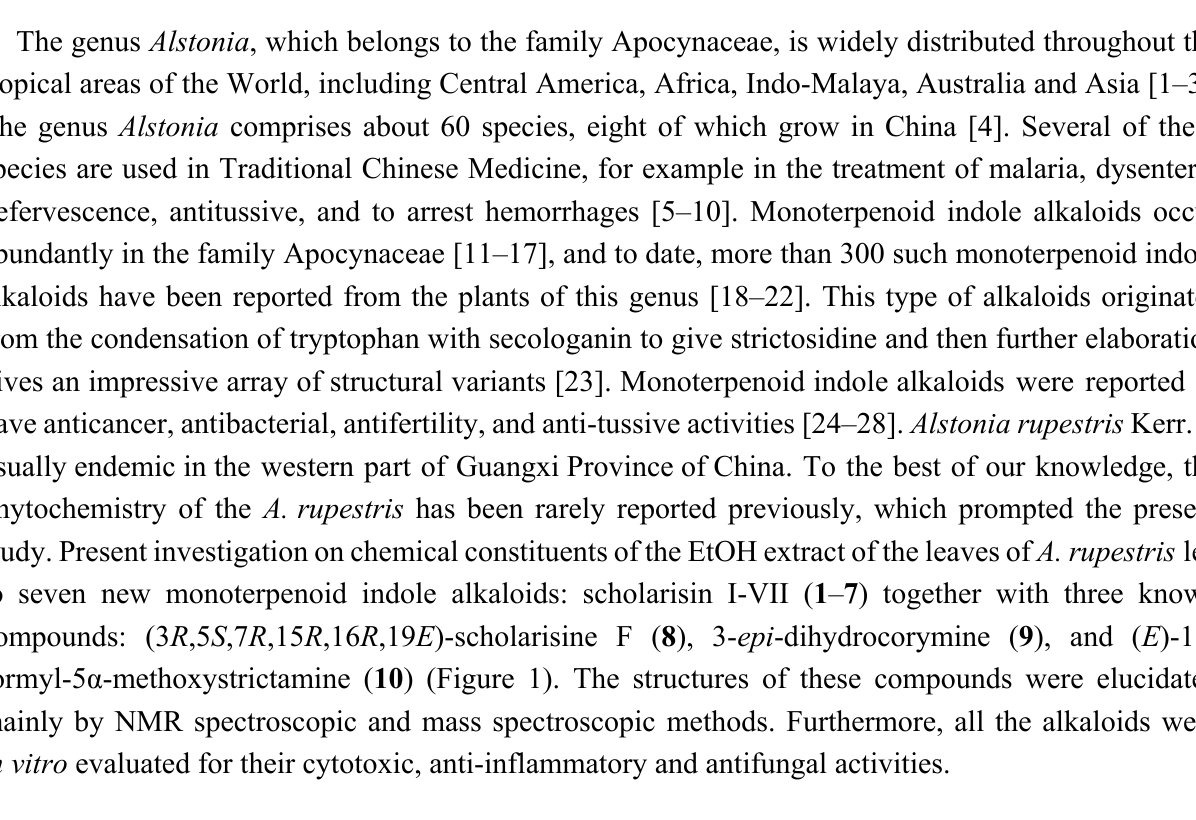
Figure 1. The structures of compounds 1 – 10